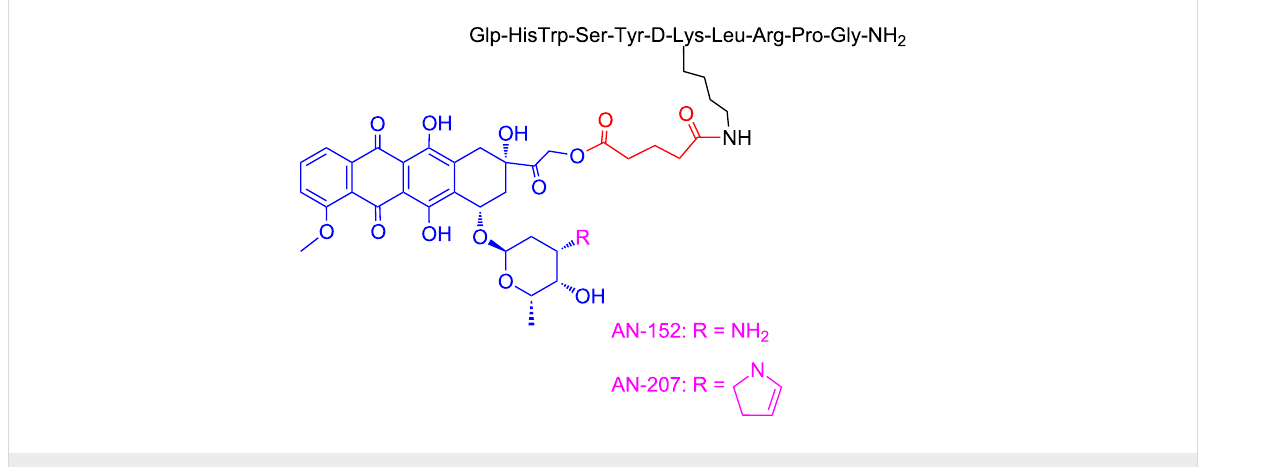
Figure 6: Structures of the PDCs named AN-152 and AN-207.